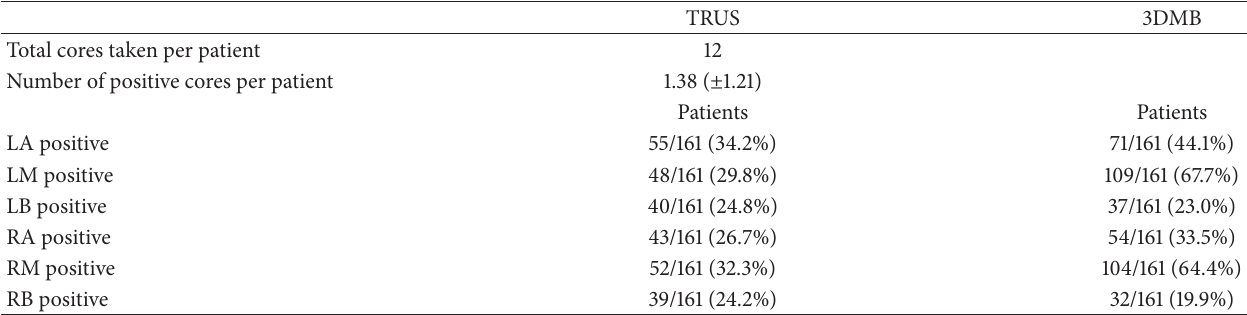
Table 2: 3DMB and TRUS-guided biopsy characteristics.